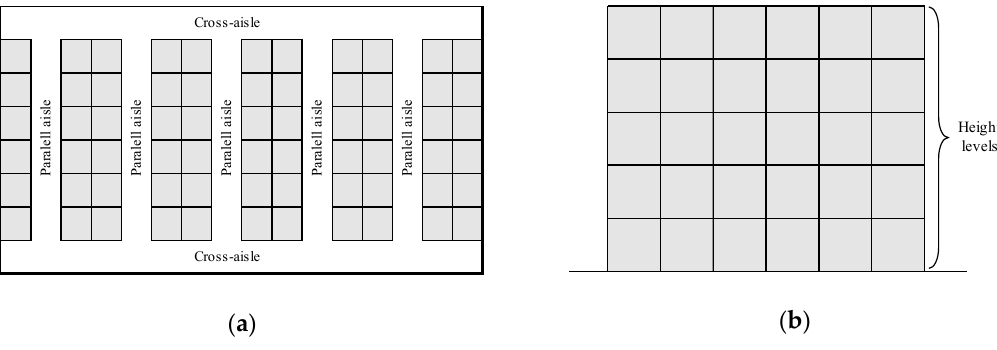
Figure 1. ( a ) Superior view of the warehouse and ( b ) front view of a parallel aisle.